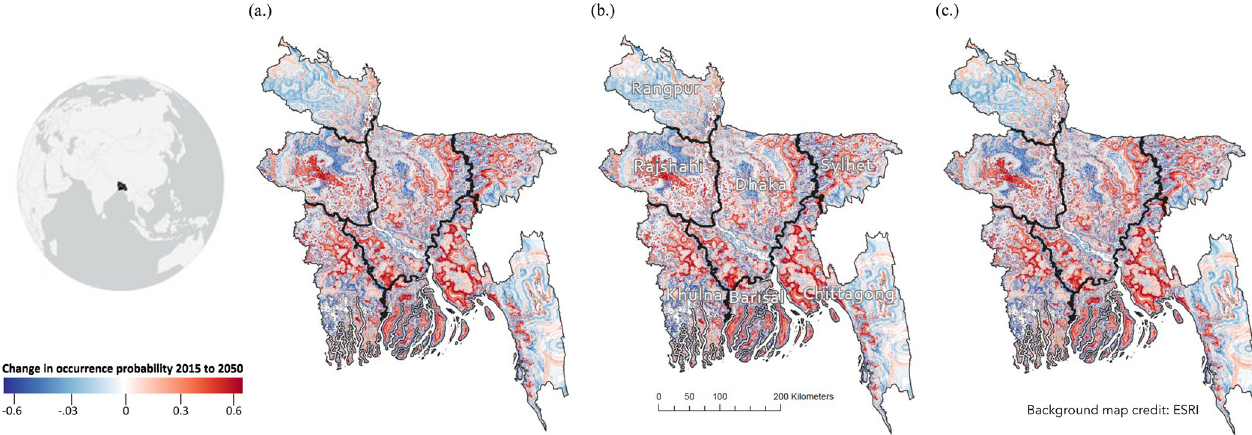
Fig 1. Change in occurrence probability (risk) from 2015–2050. Change in occurrence probability (a proxy for infection risk) from 2015 to 2050 according to the bivariate random forest model with elevation and distance to water as predictors. The (a) mean, (b) 2.5% quantile, and (c) 97.5% quantile predicted values are shown with the districts of Rangpur, Rajshahi, Dhaka, Sylhet, Khulna, Barisal, and Chittagong. S3 Fig contains the underlying occurrence probabilities for each year. Base map credit: Esri. District boundaries are provided under an open license (CC-BY) by GADM, v. 3.6